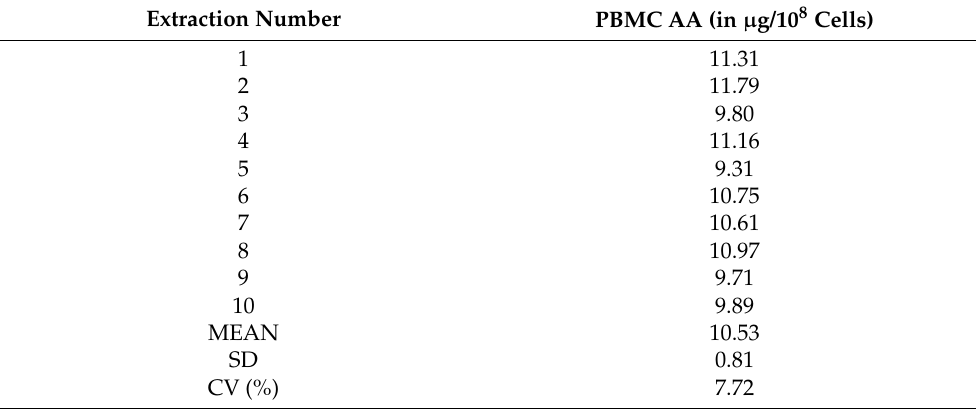
Table 2. Inter-assay variation of the intracellular measurement of the